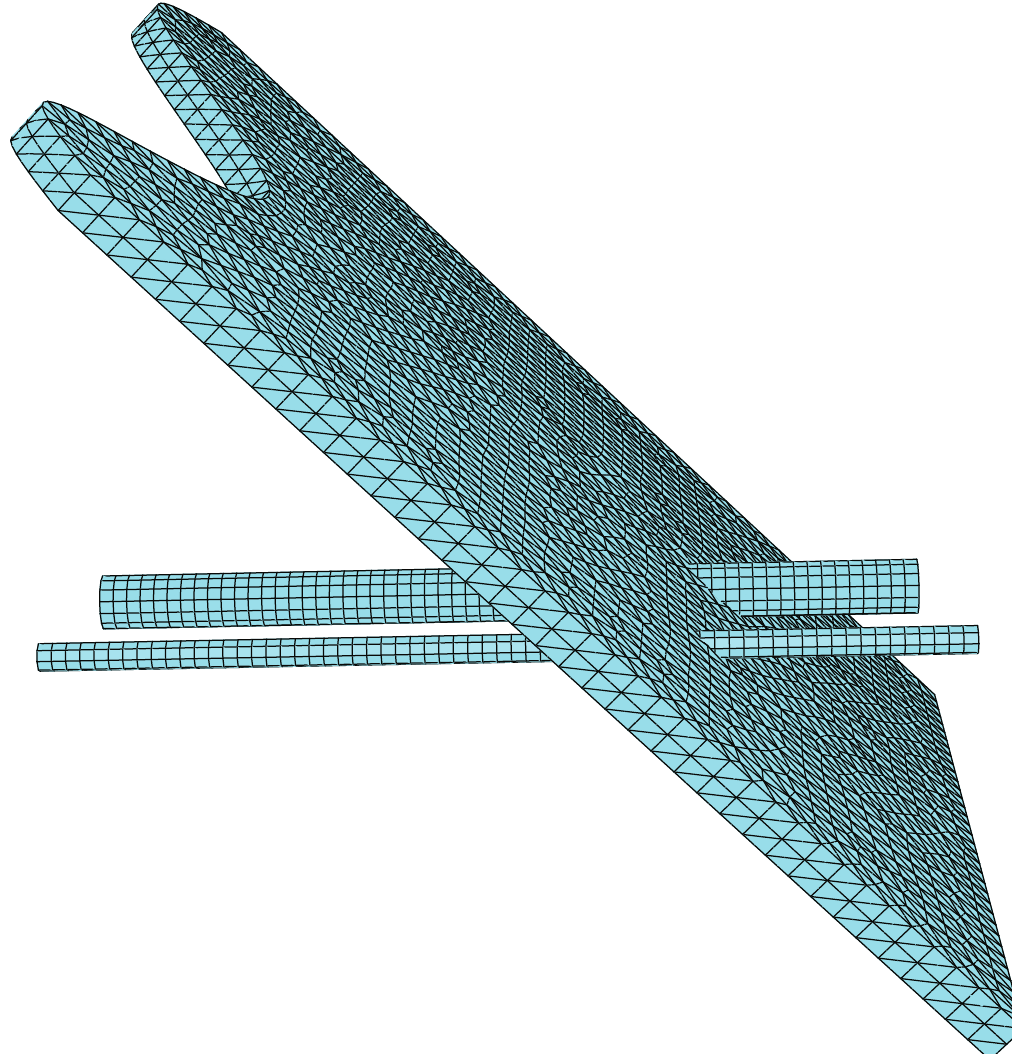
Figure 5: Cross diagram of coal seam and